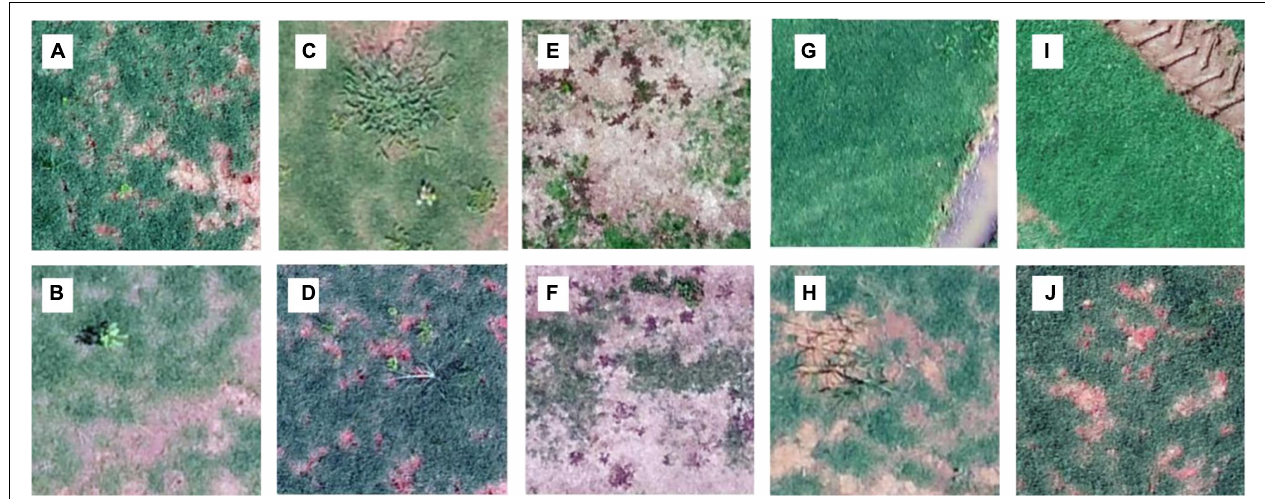
FIGURE 4 | Examples of training images for each class: broadleaf (A,B) , grass weeds (C,D) , spotted spurge (E,F) , sedge (G,H) , and no weeds (I,J) . The images were obtained through different surveys on Georgian sod farms in 2019 and